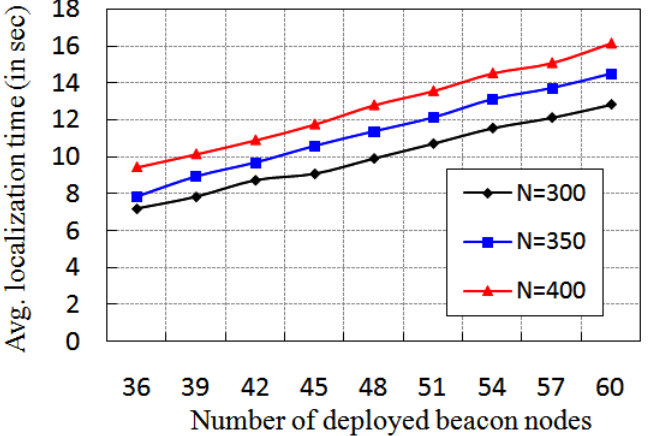
Figure 10. Average localization time for different number of beacon